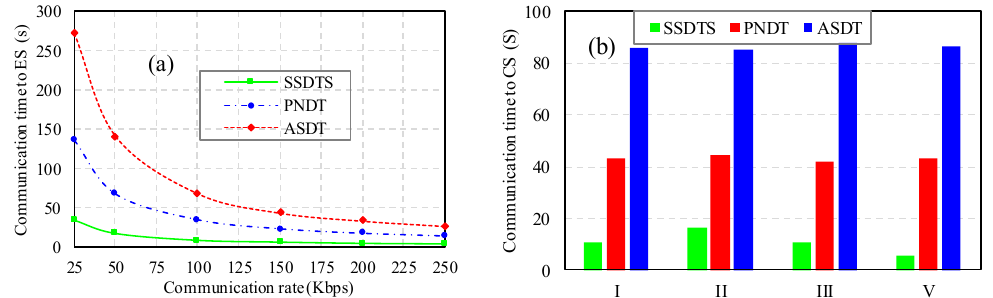
Figure 9. Communication times to the edge server and cloud server. ( a ) Communication time to the edge server, ( b ) Communication time to the cloud server.